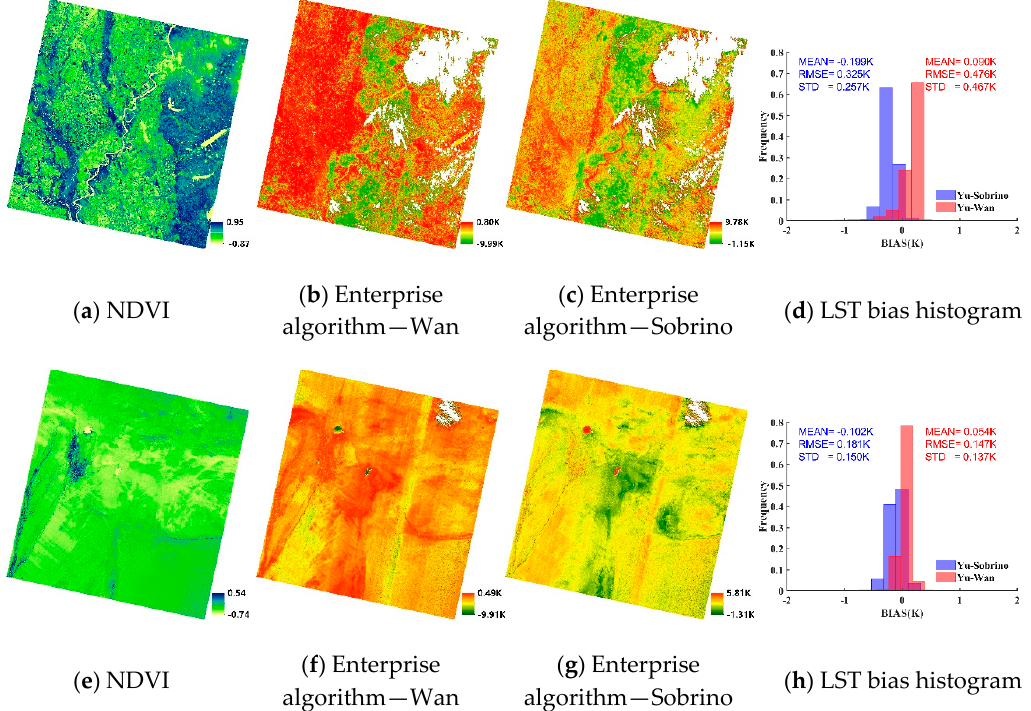
Figure 6. Normalized difference vegetation index (NDVI) images, maps of LST difference of Yu minus Wan (Sobrino), and the corresponding LST bias histograms for date of 2 May 2014 ( a – d ) and 5 May 2014 ( e – h ). ( a ) and ( e ) NDVI images of of 2 May 2014 and 5 May 2014; ( b ) and ( f ) LST difference of Yu minus Wan; ( c ) and ( g ) LST difference of Yu minus Sobrino; and ( d ) and ( h ) LST bias histogram of Yu minus Wan (Sobrino). Yu denote the Enterprise algorithm.